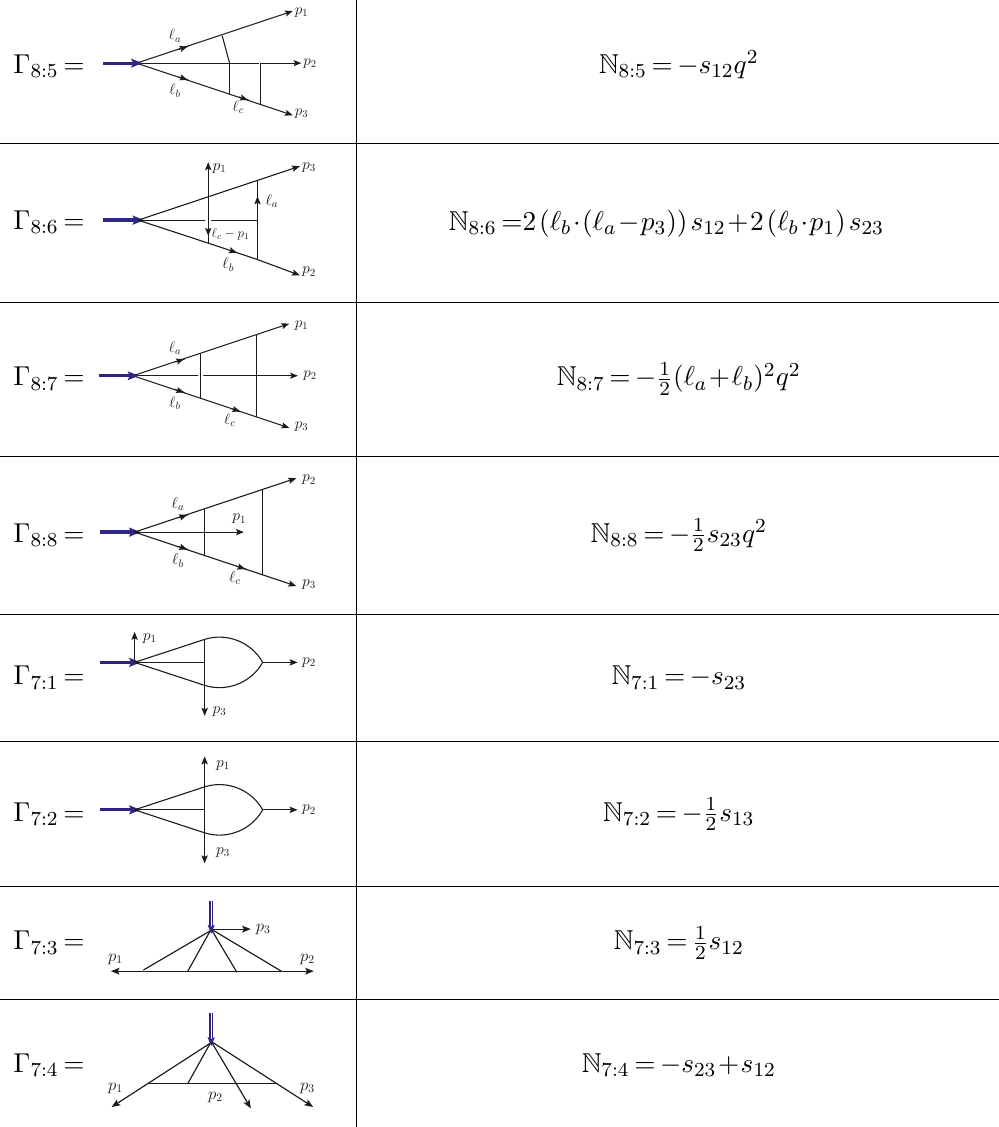
Table 5. Results of tr( φ 3 ) form factor in